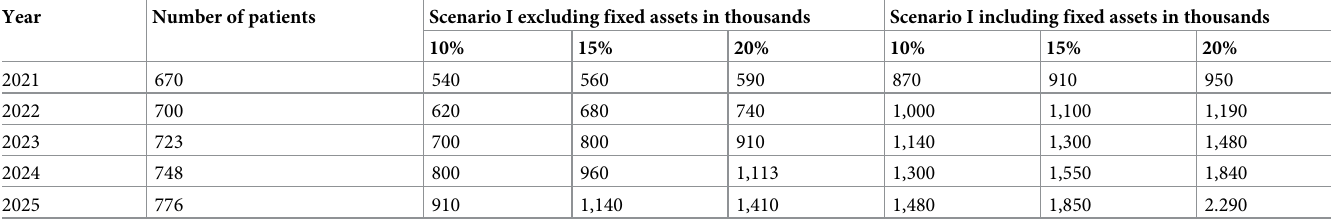
Table 6. Projection of the total costs of breast cancer treatment excluding and including the values of fixed assets from the year 2021 to 2025. Year Number of